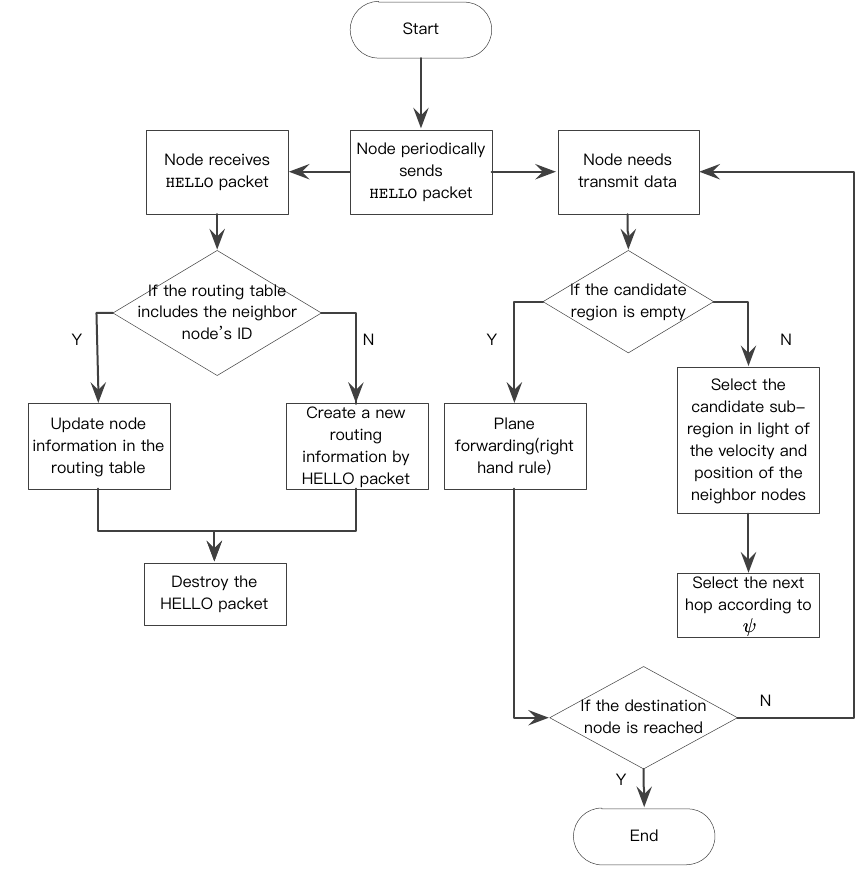
Figure 7. Flowchart of the EM-GPSR routing